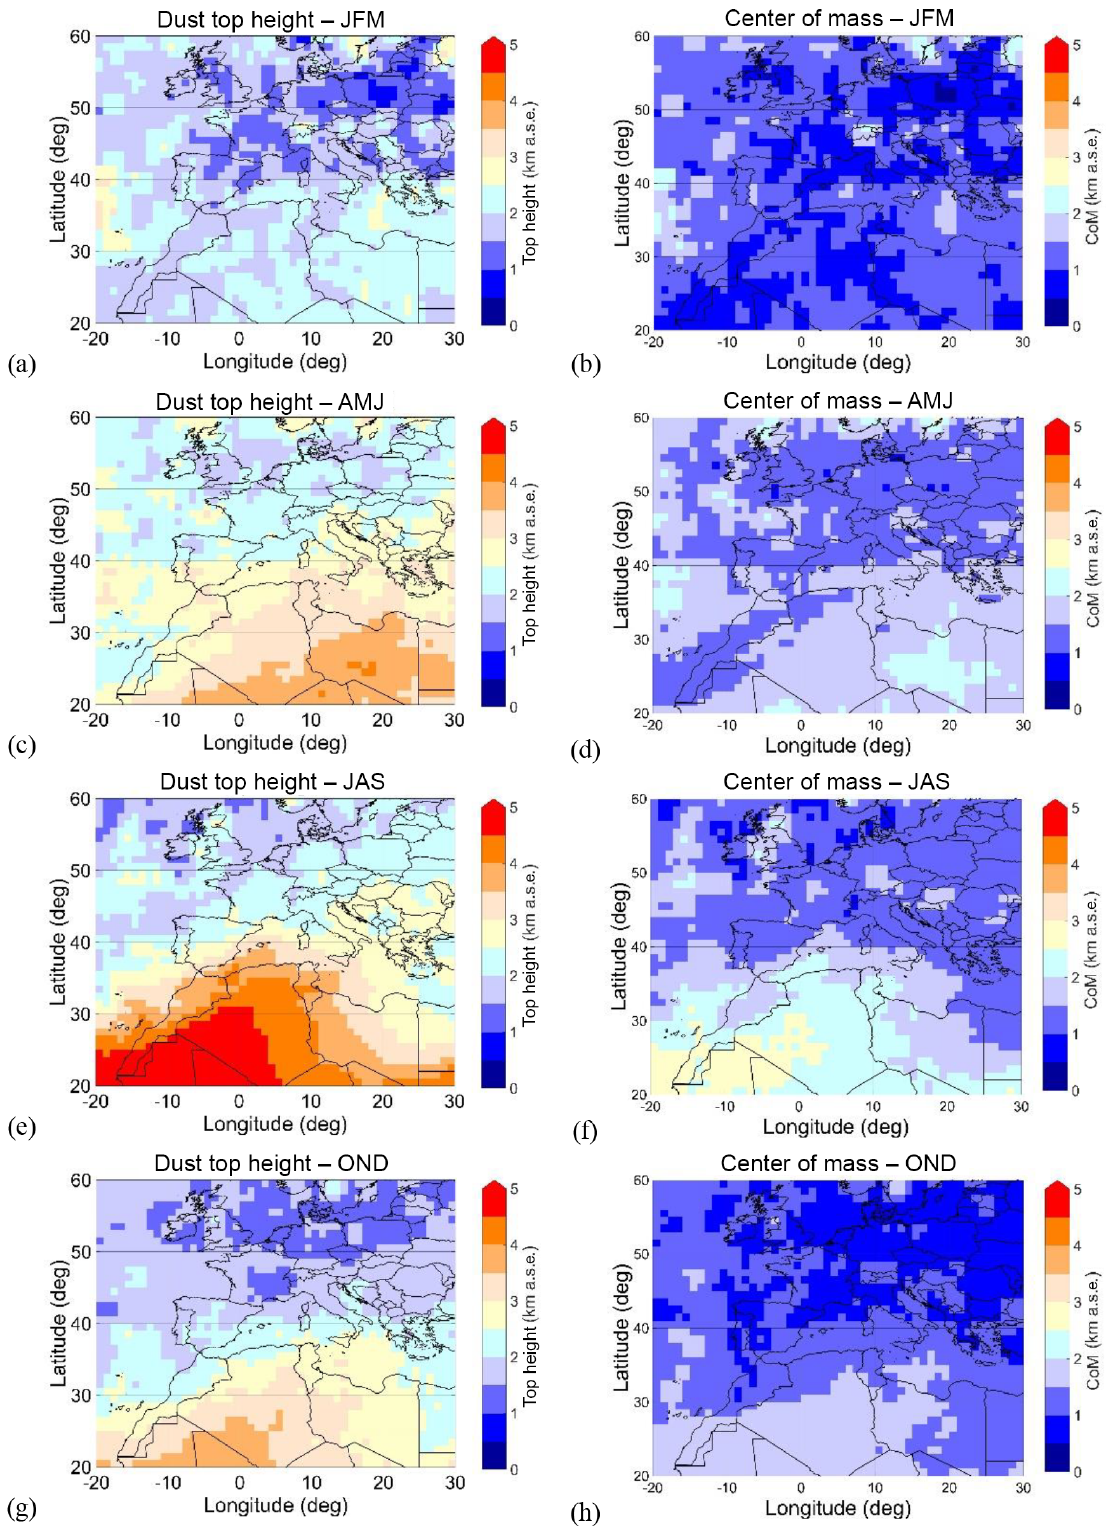
Figure 4. Geographical distribution of the dust top height (a–d) and the center of mass (e–h) in kma.s.e. measured with CALIPSO dust product for the 3-month averages: January–March (a, e) , April–June (b, f) , July–September (c, g) , and October–November (d, h) , and the domain between 20 ◦ W–30 ◦ E and 20–60 ◦ N for the period